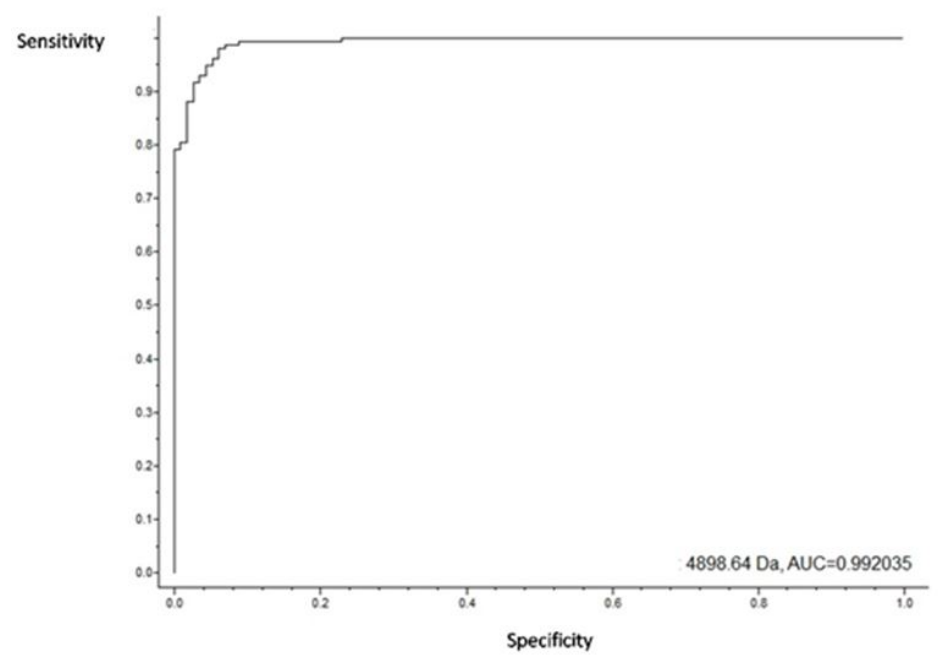
Figure 7. AUC value for the peak at m/z 4898.64. The value of the area under the ROC curve is 0.99, / z indicating a high-test pass for detecting the peak at m/z 4898.64. indicating a high-test pass for detecting the peak at m